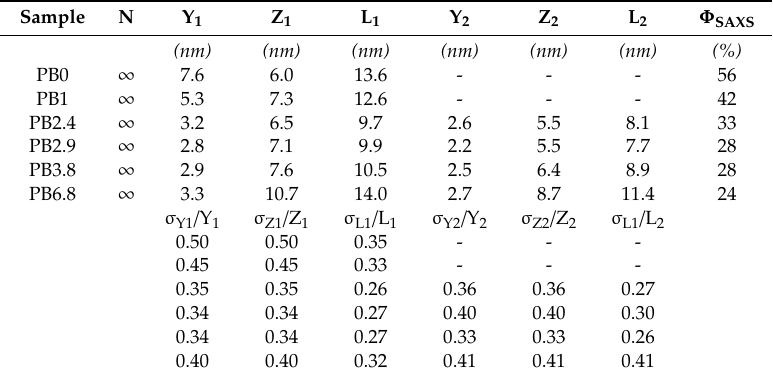
Table 4. Morphological parameters of the lamellar stacks obtained by SAXS analysis of the samples: long period (L), number of lamellae (N), thickness of the crystalline (Y), and amorphous layer (Z), along with their relative distributions, ( σ Y / Y = σ Z / Z, σ L / L) and the degree of crystallinity by volume ( Φ SAXS ). Sample N Y 1